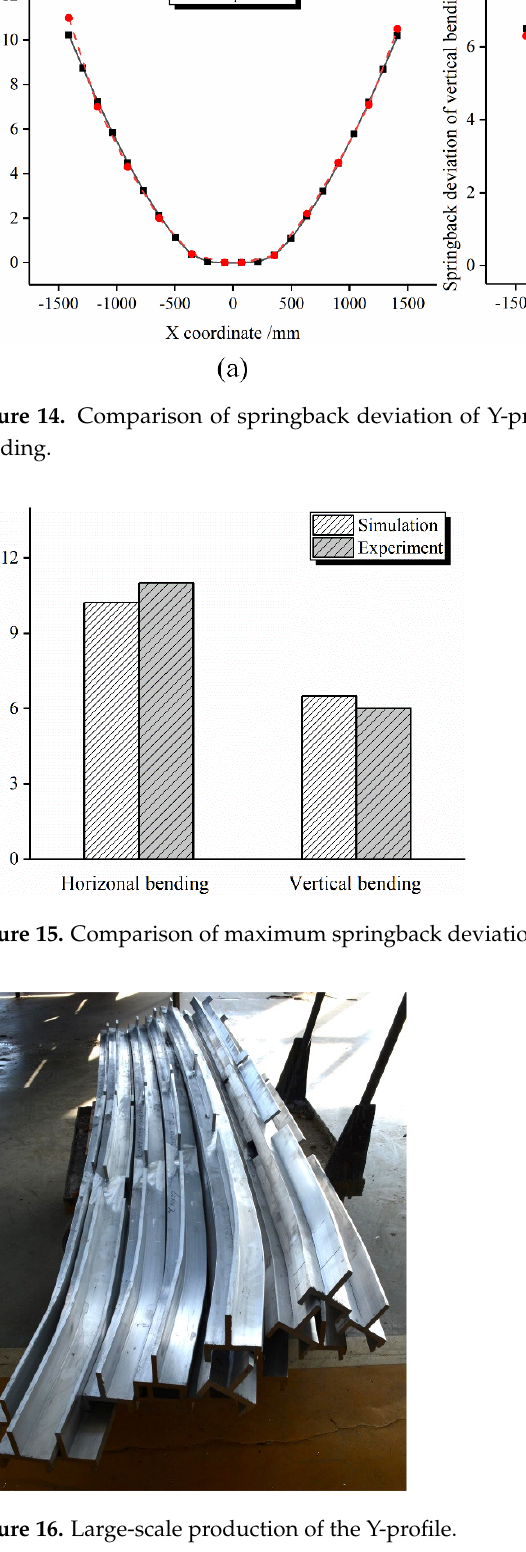
Figure 16. Large-scale production of the